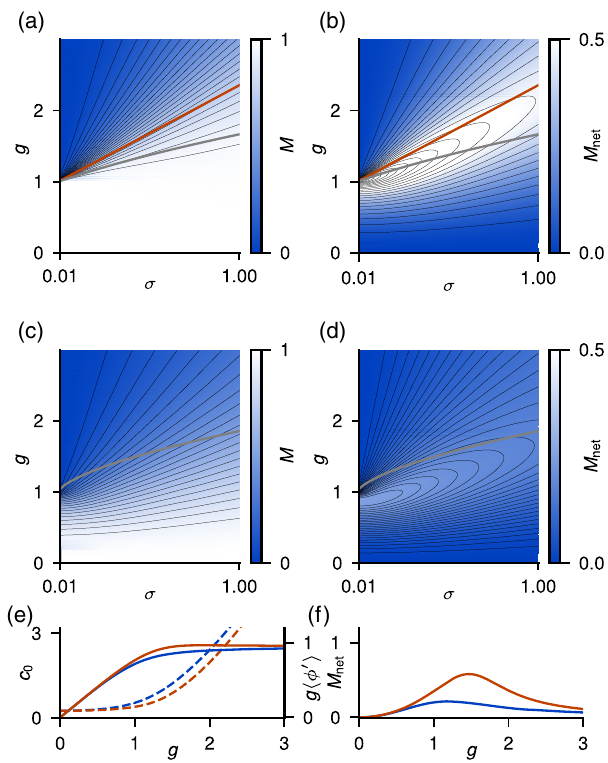
FIG. 7. Memory capacity in different phases of the network dynamics. (a) Total memory capacity (30) encoded in color. We show the transition curve (20) between regular and chaotic dynamics (red) and the necessary condition (18) of local instability (gray) as in Fig. 3. Contour lines of memory are shown in black. (b) Same as panel (a) for the network contri- bution to memory capacity. Panels (c) and (d) are the same as panels (a) and (b) but for quenched background noise. (e) Self- consistent c 0 (dashed curve) and g h ϕ 0 i (solid curve) for white- noise input (red) and quenched-noise input (blue) for σ σ ¼ 0 . 5 . (f) Network contribution to memory capacity q ¼ M for white-noise input (red) and quenched-noise input net